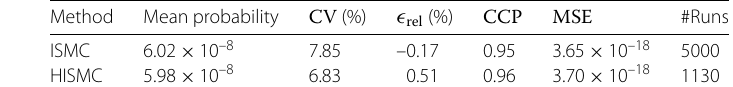
Table 8 Memory cell: ISMC versus HISMC probability estimation